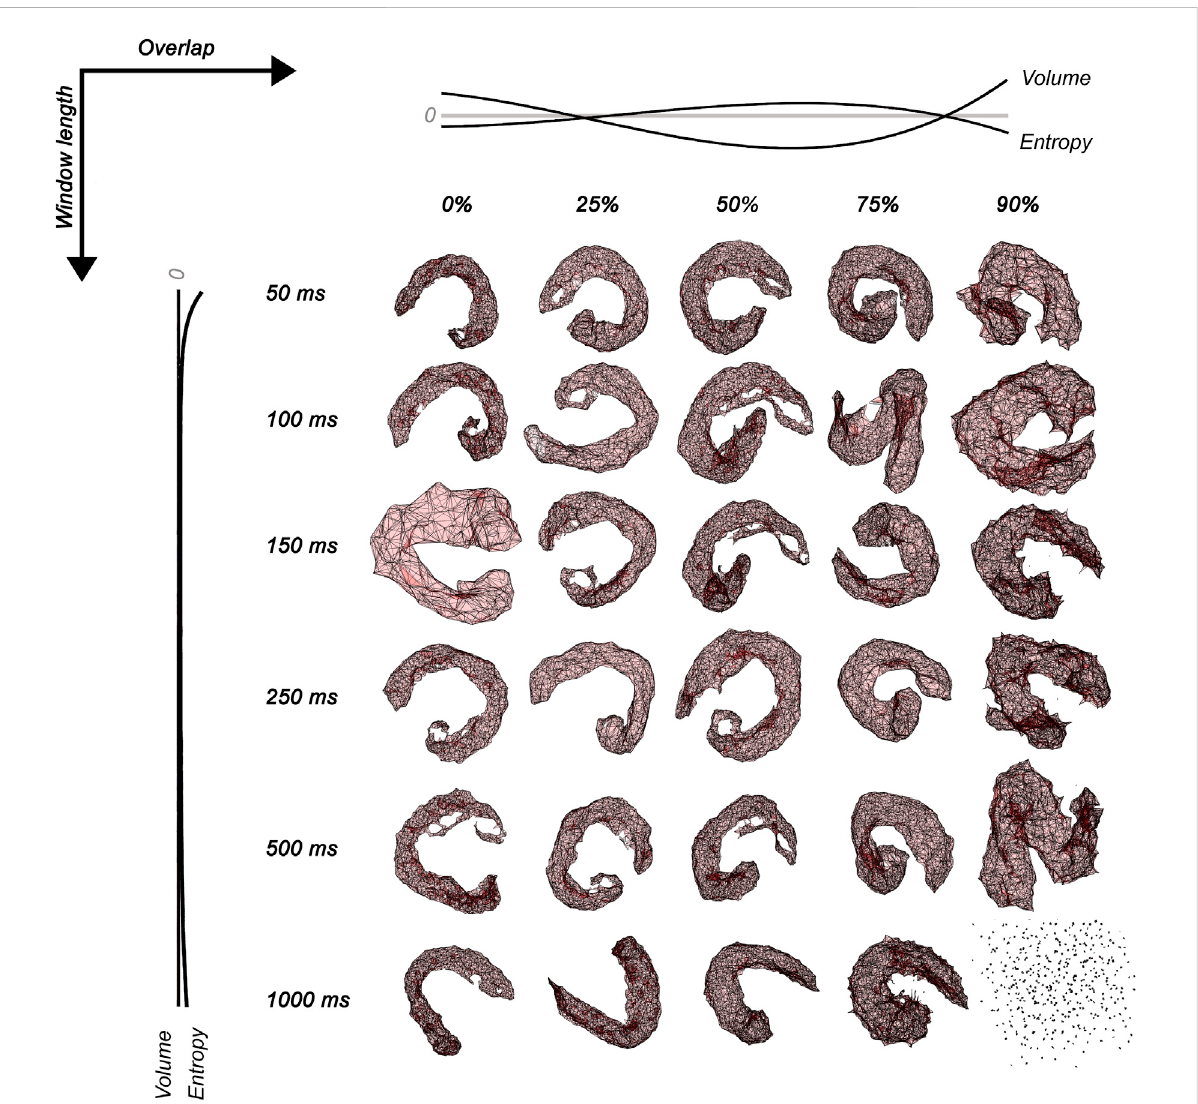
FIGURE 2 Surface electromyographic maps embedded in three dimensions for 30 conditions of signal processing varying window lengths (50 ms, 100 ms, 150 ms, 250 ms, 500 ms, and 1,000 ms) and overlap (0, 25, 50, 75, and 90%). The normalized no-linear fi tting for the Shannon entropy and volume of sEMG polyhedrons is also shown in dark lines. Notice that the combination of 1000 ms and 90% of overlap projects no simplexes